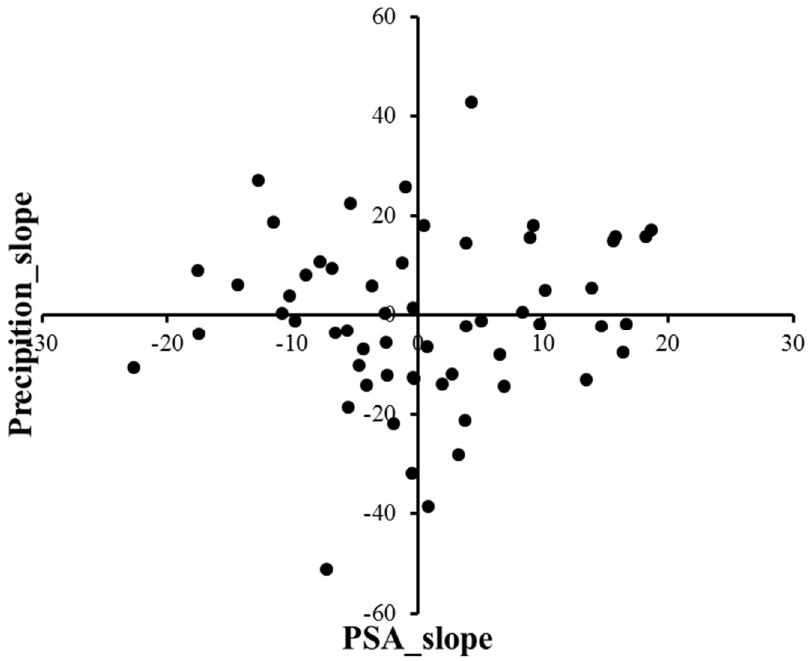
Figure 8. Scatter map of the trends of albedo and precipitation in the 58 stations from 2000 to